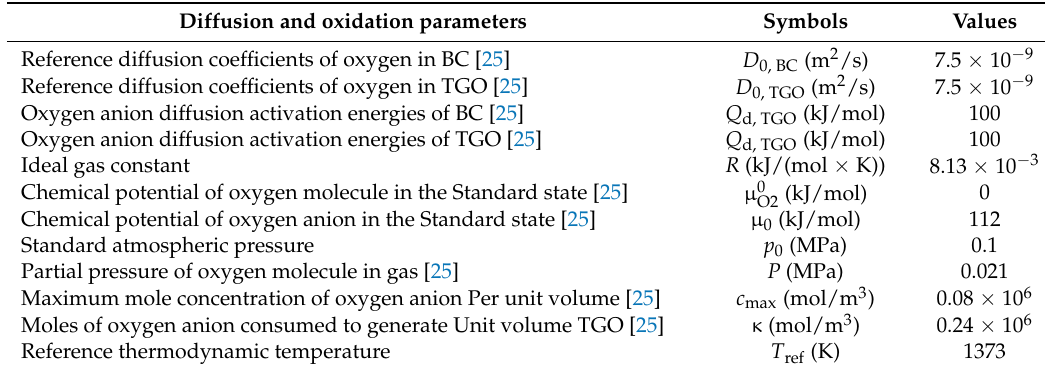
Table 4. Diffusion and oxidation